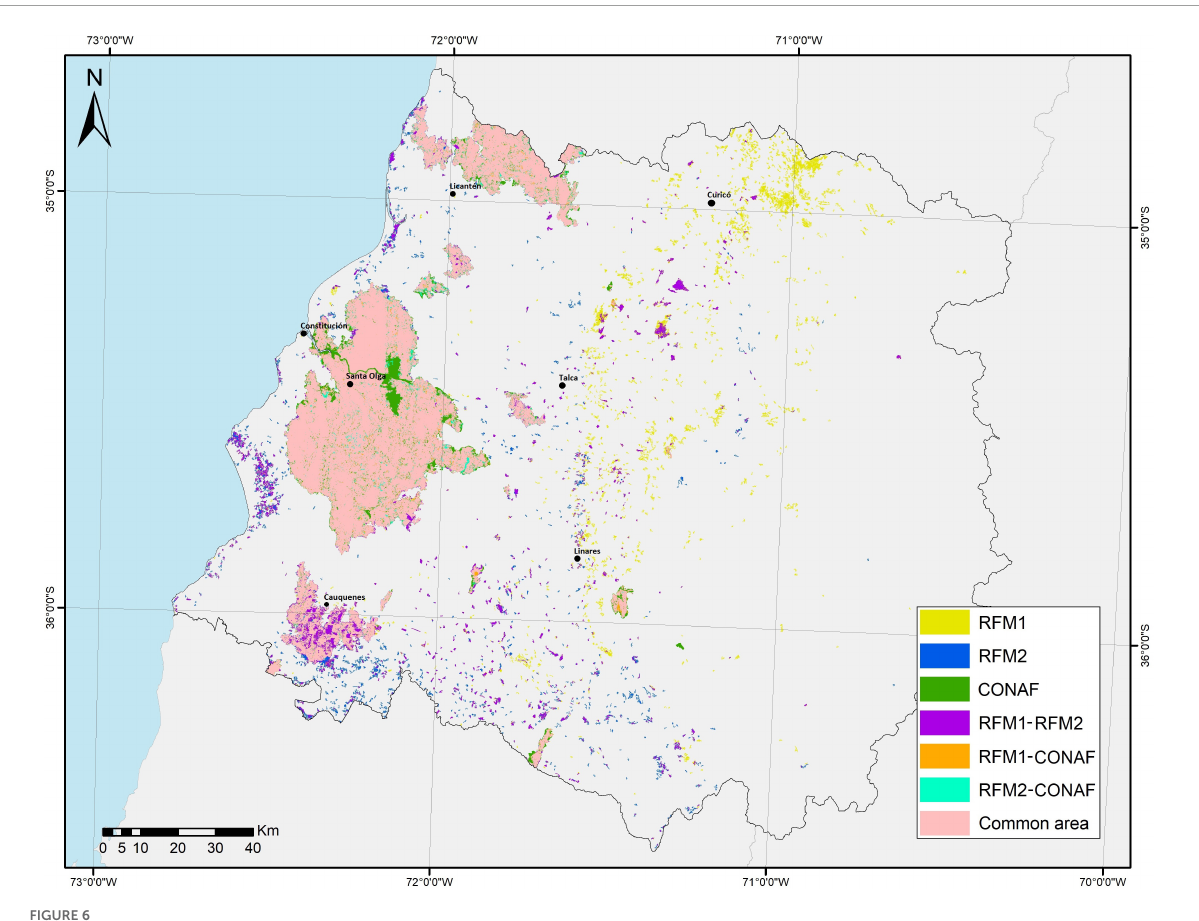
FIGURE6 Comparative analysis of the classification of the burned area generated by the two results of the Random Forest algorithm, RF M1 and RF M2 , the official CONAF perimeters, and the areas where two of the burned area maps overlapped. Only the land covers with the greater differences are represented.